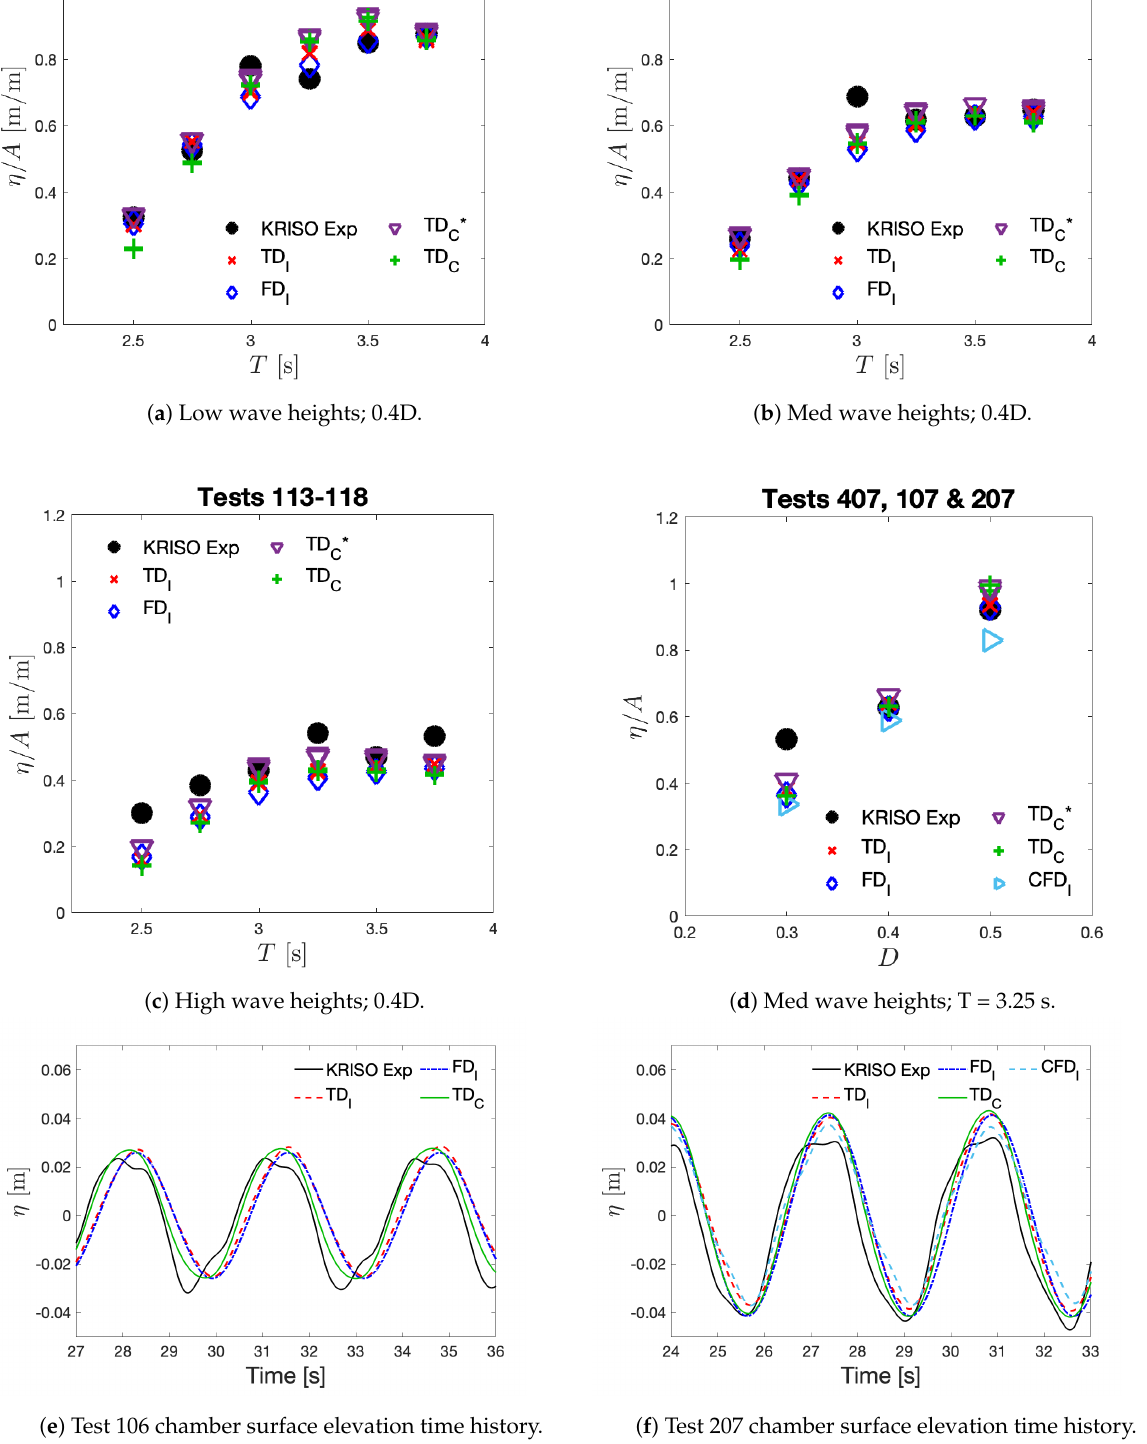
Figure 21. Comparison of the internal chamber surface: ( a – c ) cases with low, med and high wave heights and an orifice plate size of 0.4D; ( d ) tests with orifice plate sizes corresponding to 0.3 D , 0.4 D , and 0.5 D in med wave height; and ( e , f ) chamber surface elevation time history for Tests 106 and